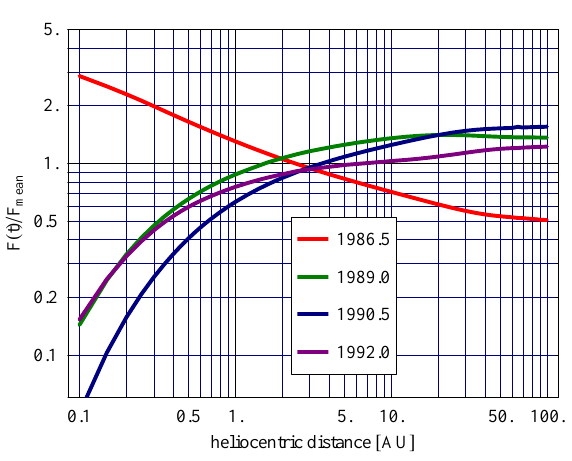
Fig. 17. Slope of f PUI (r,θ,t) at r = 1 AU, defined in Eq. (12), as a function of speed normalized to solar wind speed: w = v/V in the directions upwind, crosswind, and downwind, color-coded in the inset box, for the epoch of solar minimum ( t = 1986 . 5).